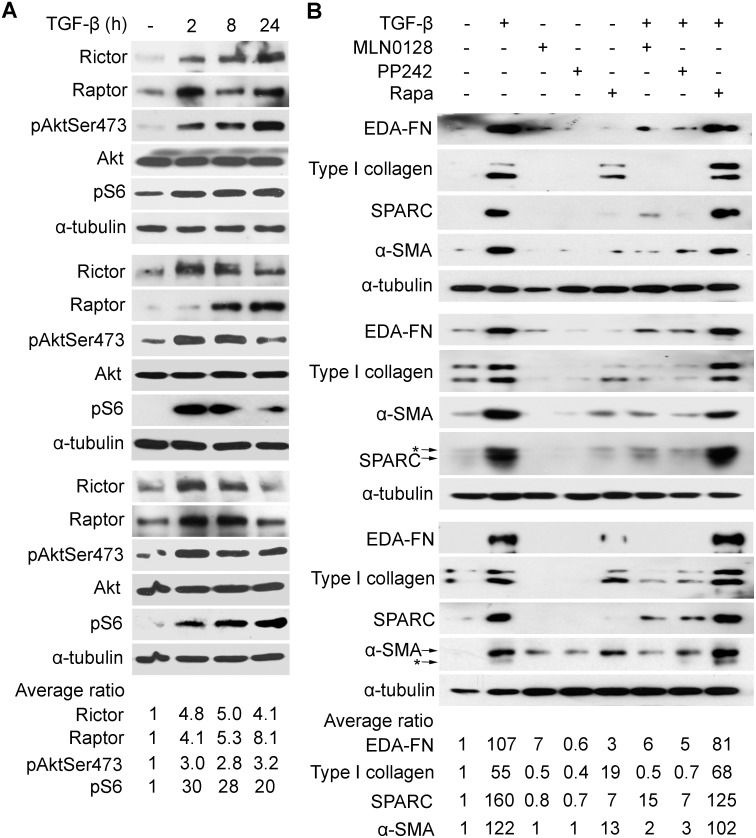
Rictor is a target of TGF-β and the effect of mTOR inhibitors on TGF-β signaling in IPF lung fibroblasts.IPF fibroblasts (<passage 8) isolated from surgical lung biopsy (top panel) or lung transplant patients (middle and lower panels) were serum-starved for 24 hours prior to treatment. In (A) cells were treated with TGF-β (5 ng/ml) for time as shown; (B) cells were treated with TGF-β (5 ng/ml) overnight or left untreated in the presence or absence of indicated inhibitors MLN0128 (0.2 µM), PP242 (2 µM), or rapamycin (Rapa, 0.05 µM), which were added 30 minutes prior to TGF-β. Total cell lysates were prepared and equal amounts of protein were analyzed by Western blot analysis with specific antibodies as indicated. α-tubulin was used as a loading control. Asterisk indicates the carry-over signals between the western blots of α-SMA and SPARC. Band intensity was determined by using Image J software from the NIH. Data was presented as band intensity relative to untreated samples. EDA-FN, extra domain A fibronectin; SPARC, secreted protein acidic and rich in cysteine; α-SMA, α-smooth muscle actin.